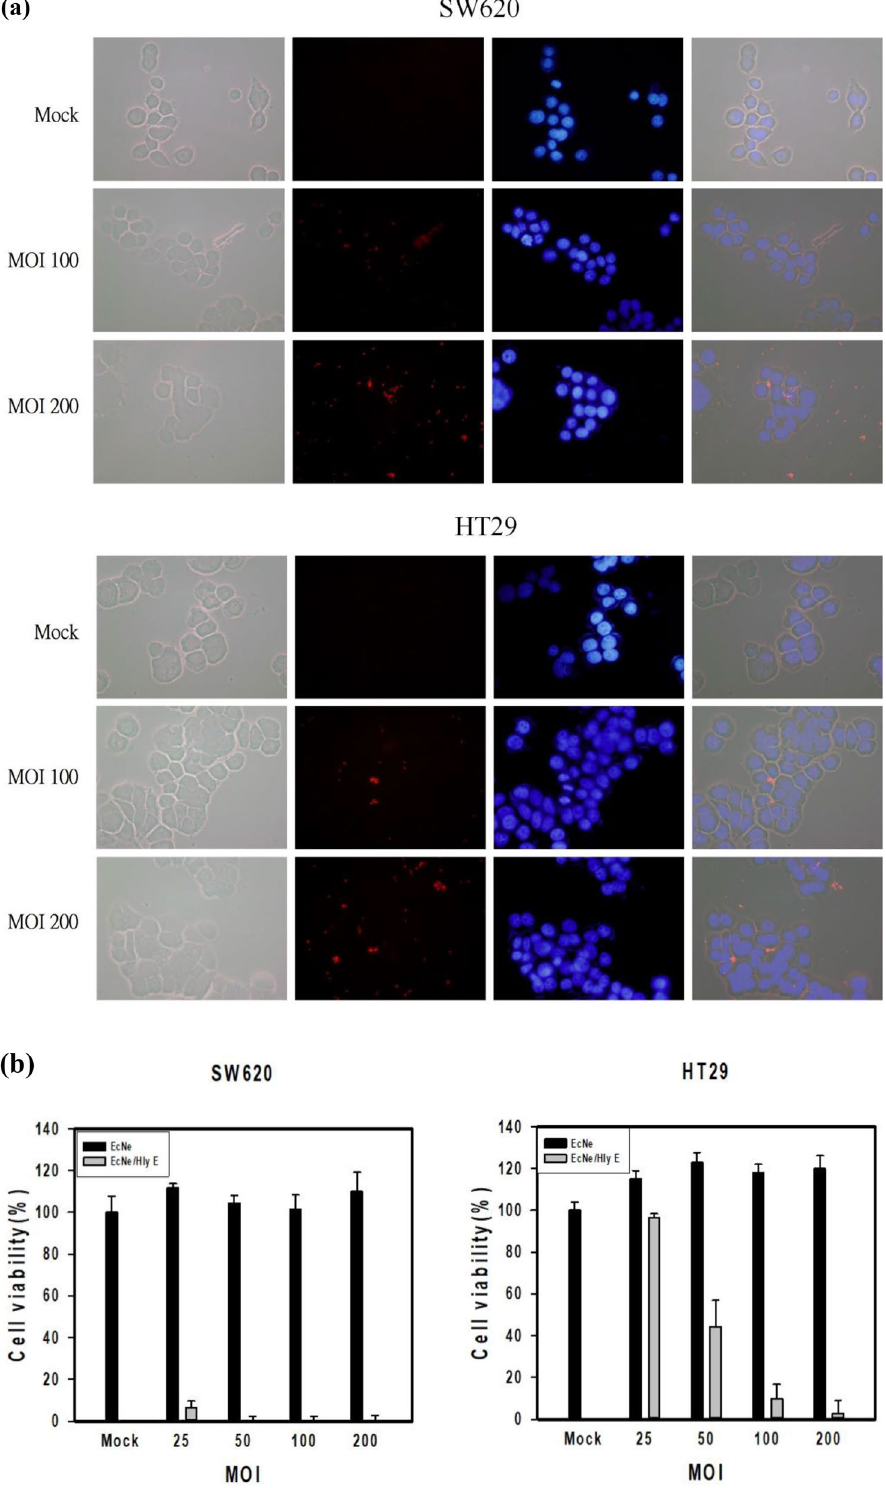
Figure 4. In vitro toxicity of EcNe/HlyE. ( a ) The specific attachment of EcNe to tumor cells. ( b ) Examination of cell viability by MTT assay. SW620 or HT29 cells were incubated with either EcNe or induced EcNe/HlyE at various MOI as indicated for 3 h. ( c ) Time-lapse images of cell nuclear morphology by DAPI staining. Images of SW620 and HT29 cells were taken over time as indicated on the top upon administration with either EcNe or induced EcNe/HlyE at MOI of 100. Bacteria were identified in red. ( d ) Time-lapse images of cell nuclear morphology by PI staining. Arrows indicate internal rearrangement of organelles and loss of membrane integrity. Cell images were processed with GEN5 3.0 software